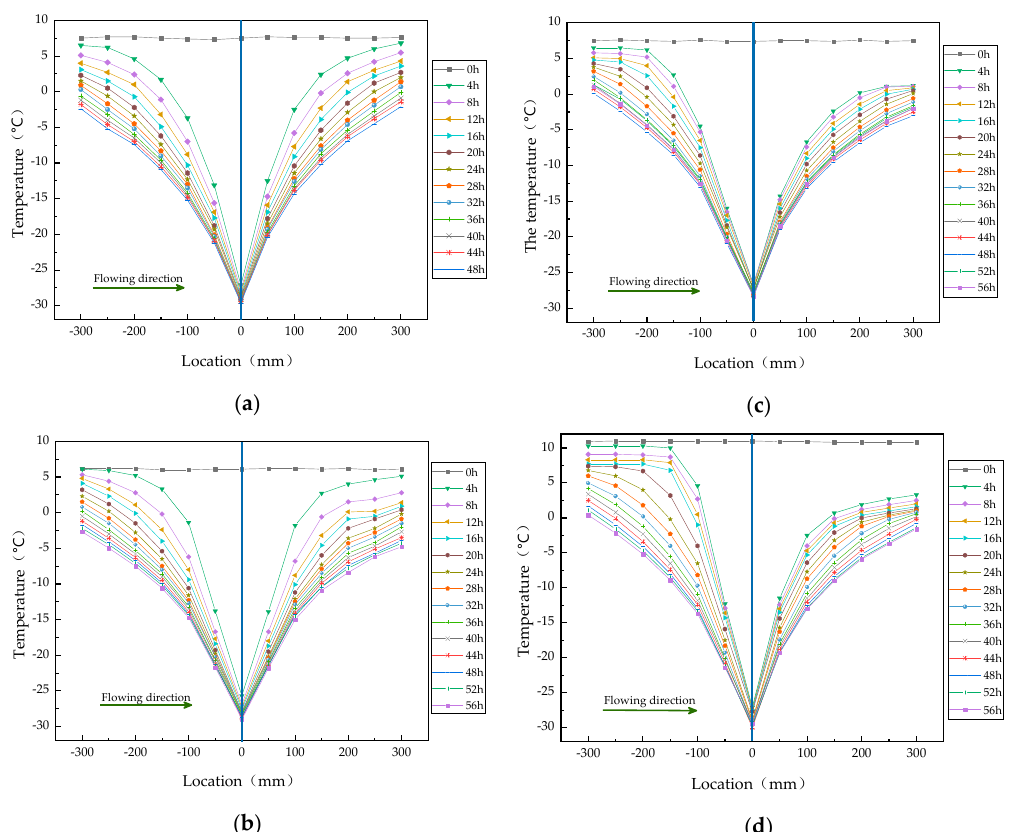
Figure 9. Spatial distributions of temperatures on the B axis at: ( a ) 0 m/d; ( b ) 3 m/d; ( c ) 6 m/d; ( d ) 9 m/d.